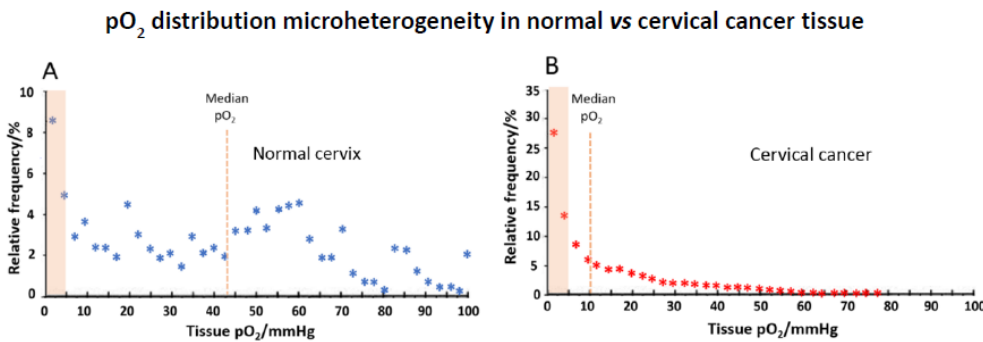
Figure 7. Percentage frequencies of pO 2 measured across ( A ) Normal uterine cervix (seven patients, 432 samples), ( B ) Cervical cancer (150 patients, 13596 samples). Shaded areas highlight percentage prevalence of extreme tissue hypoxia of < 5 mmHg. Each set of data represents combined data points from multiple patient samples. Adapted from [68].